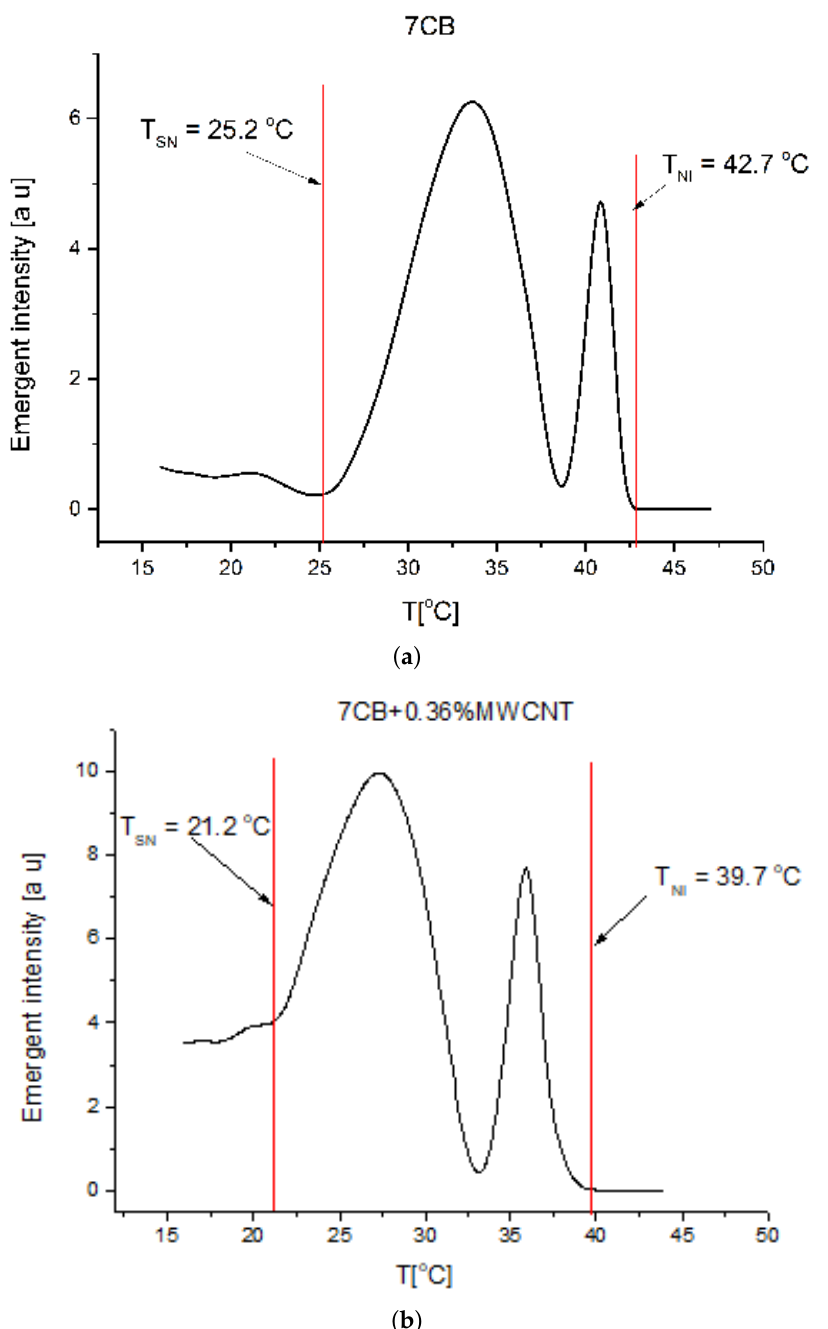
Figure 5. Emergent intensity versus temperature ( a ) for 7CB and ( b ) for 7CB + 0.36% MWCNT. For the capacity measurements, the laser source was switched off and the the acquisi- tion system was enabled. The parallel capacitance was determined for the homeotropic cell and the perpendicular capacity was measured in the homogeneous aligned cell. The obtained values were adjusted by the capacitances of the empty cell.The dielectric permittiv- ities were calculated from the capacitances by multiplying them with the thickness/active area ratio (the active area of each sample is 1 cm 2 and the thickness is 15 microns). The results are presented in (Figure 7). For the temperature depending plots, the LC cell was placed in the hot stage of a Mettler-Toledo thermo-stabilized heat source in which the temperature can be set by a precision of 0.01 degrees